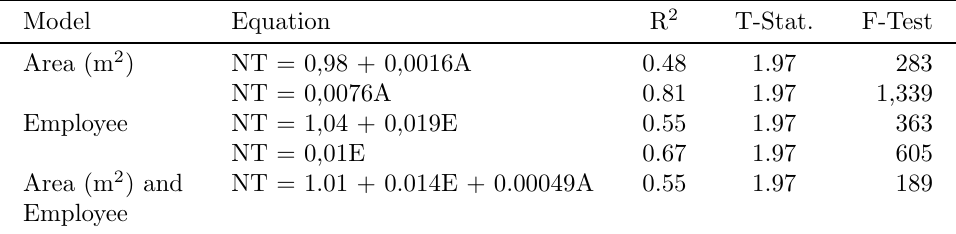
Figure 3: The geographical dispersion of Bars and Restaurants in Belo Horizonte Table 3: Freight trip generation model to bars and